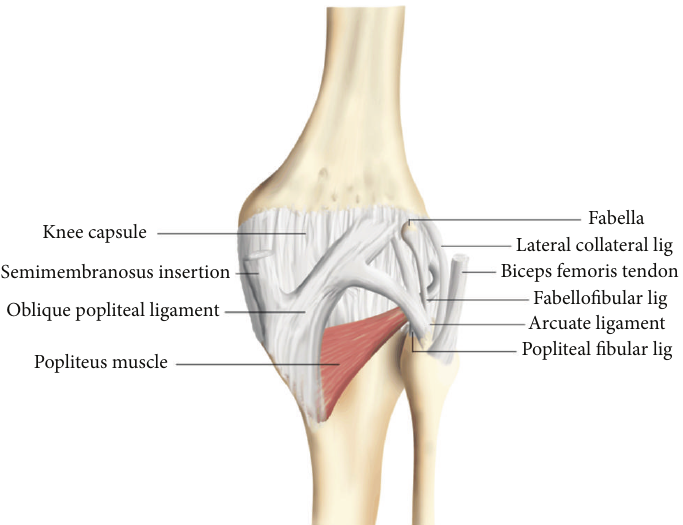
Figure 1: Posterolateral ligamentous complex of the knee including arcuate ligament, fabellofibular ligament, popliteal-fibular ligament, lateral collateral ligament, and biceps femoris tendon (case courtesy of Dr. Frank Gaillard, http://radiopaedia.org/). The fabella is located in the posterior aspect of the knee where lines of tensile stress intersect [14]. It articulates with the posterior part of the articular surface of the lateral femoral condyle and is embedded in the muscular fibres of the gastrocnemius muscle [14]. Anteriorly the fabella is bordered by the posterior capsule of the knee joint and posteriorly it is situated at the endpoint of the oblique popliteal ligament and the lateral gastrocnemius tendon [14]. In addition, the fabellofibular ligament runs to its distal insertion at the styloid process of the fibular head [14].